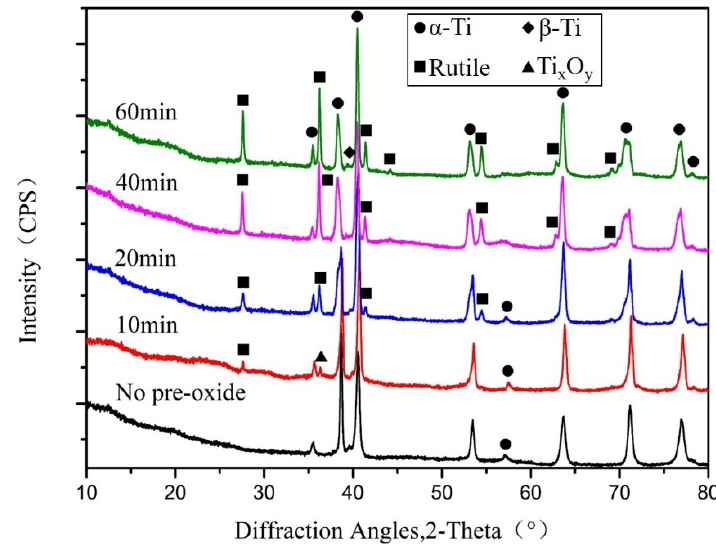
Figure 2. XRD patterns of initial and pre-oxidized specimens for 10, 20, 40, 60 min at 700 °C.